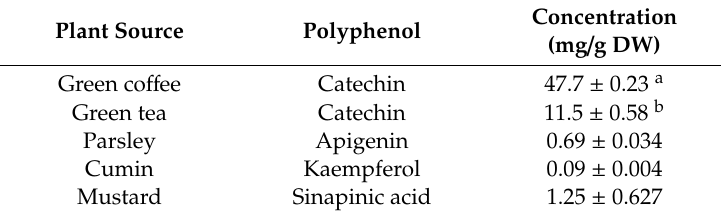
Table 1. Concentration of chosen polyphenols in ethanol extracts ( n =